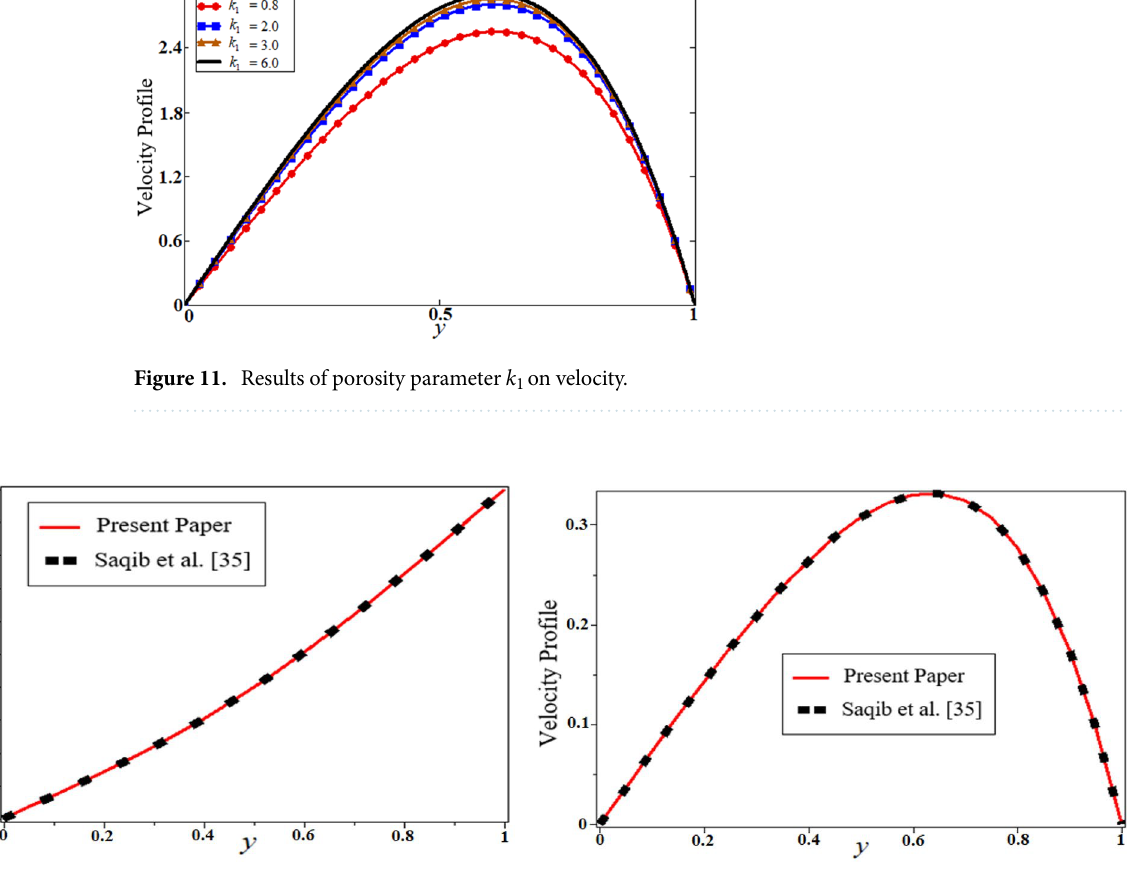
Figure 12. Comparison plot of the present solution with Saqib et al . 40